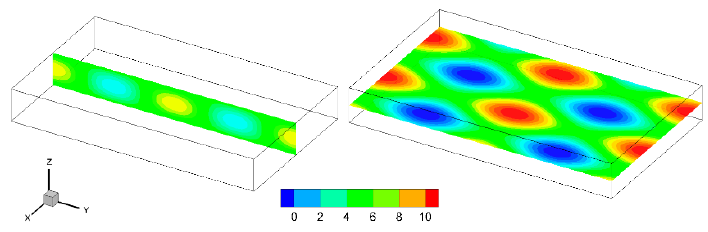
Figure 3. Permeability distribution measured in meters per day.